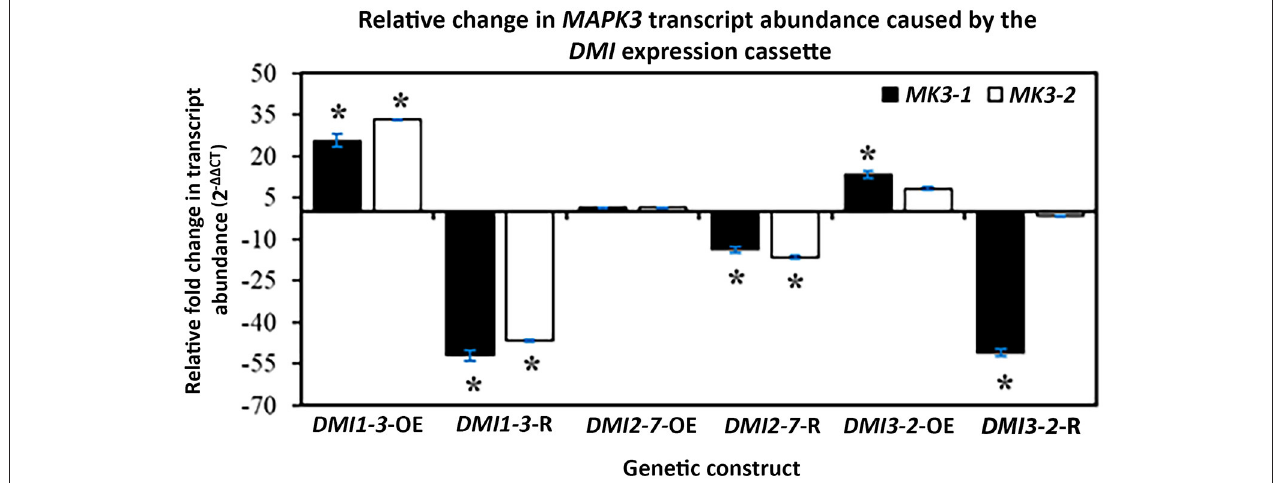
FIGURE 6 | The effect that DMI1 , DMI2 , and DMI3 -OE or -RNAi had on the RTA, presented as FC, of MAPK3-1 , and MAPK3-2 , confirmed by RT-qPCR as calculated by 2 − 11 C T (Livak and Schmittgen, 2001). (*) p < 0.05, Student’s t -test (Yuan et al., 2006). Please refer to Materials and Methods subsection: Real-time quantitative PCR (RT-qPCR), for